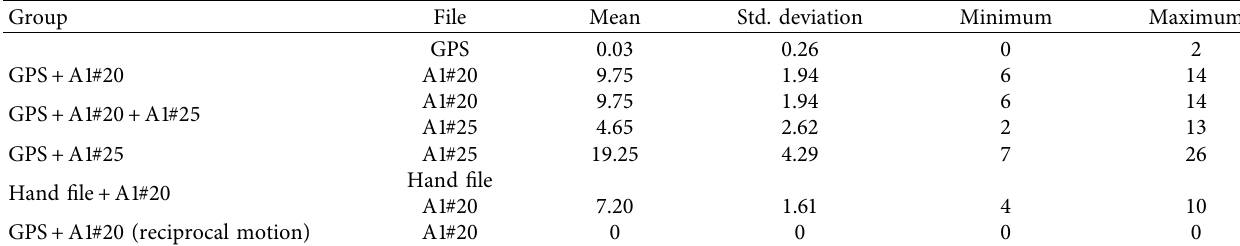
Table 3: Number of autoreverses (GPS is in a single row because it was used in different groups).